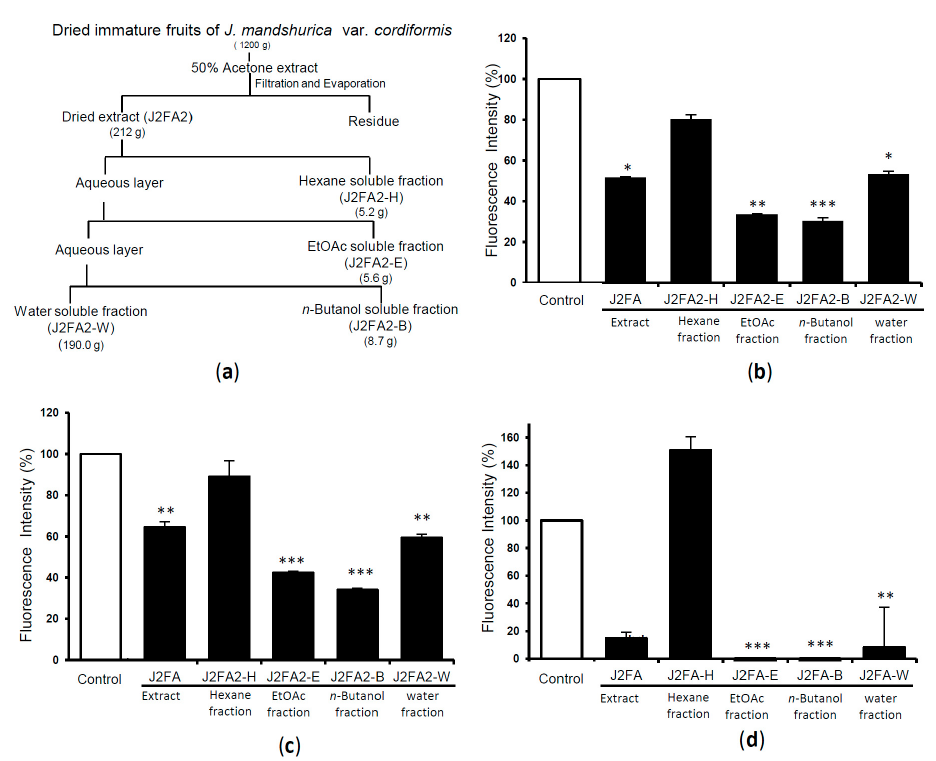
Figure 3. Scheme representing liquid-liquid extraction procedure and extraction yield ( a ); The amyloid fibril disrupting capacity of extract and different fractions (0.5 mg/mL) of immature fruit extract of J. mandshurica plants, when incubated with V30M-TTR tetramer ( b ) and WT-TTR tetramer ( c ) for 24 h, then quantified with ThT assay. Quantification was performed by with PROTEOSTAT ® Protein aggregation assay following similar procedures using V30M-TTR ( d ). Data sets were analyzed by Tukey-Kramer multiple comparison test. * p < 0.05; ** p < 0.01; *** p < 0.001 as compared with control (respective TTR treated with DMSO in each experiment); All experiments were performed in triplicate (means ± SEM, n = 3).